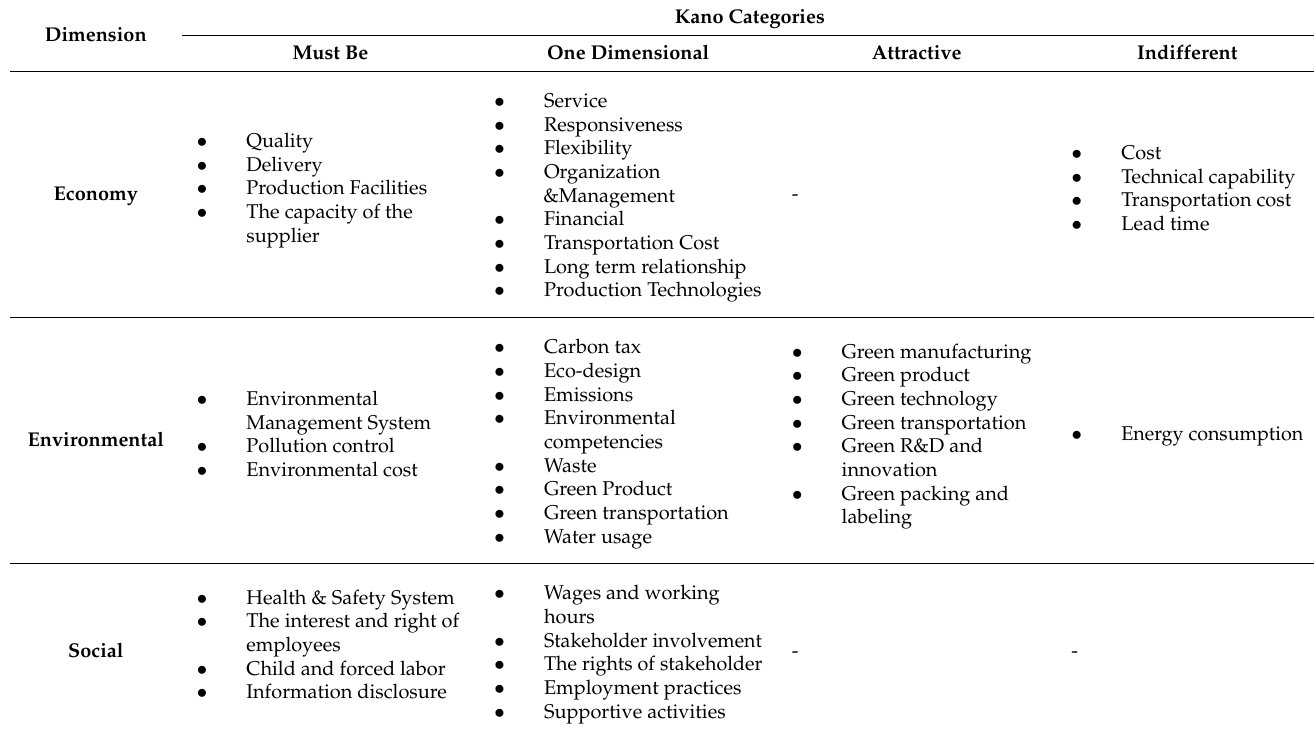
Table 3. Classification of sustainability criteria through the Kano